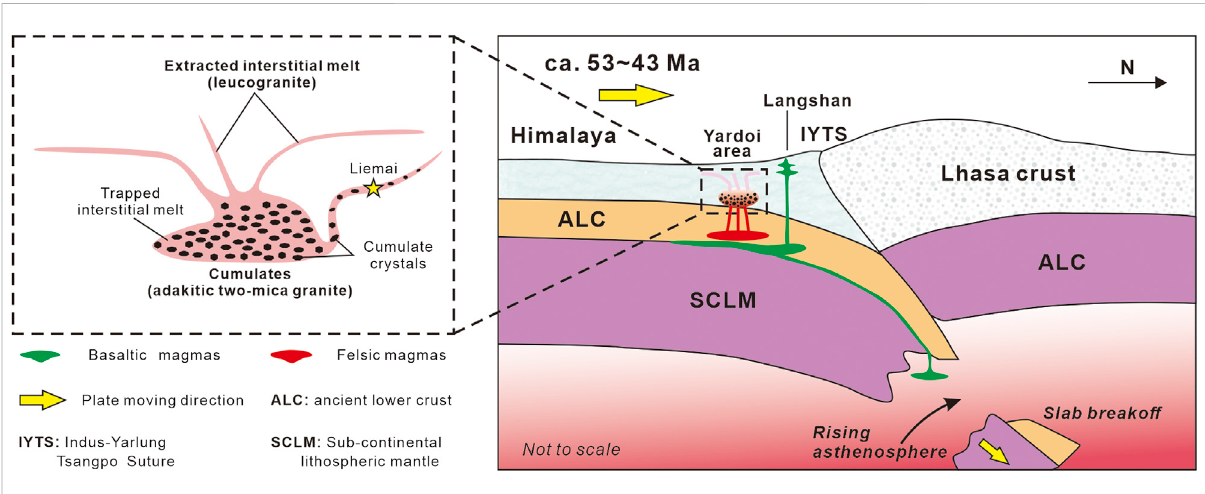
FIGURE 15 SchematicillustrationshowsthegeodynamicsettingandformationoftheEarlyEocenegranitesintheYardoiarea.TheLangshangabbroisfrom Ji et al.